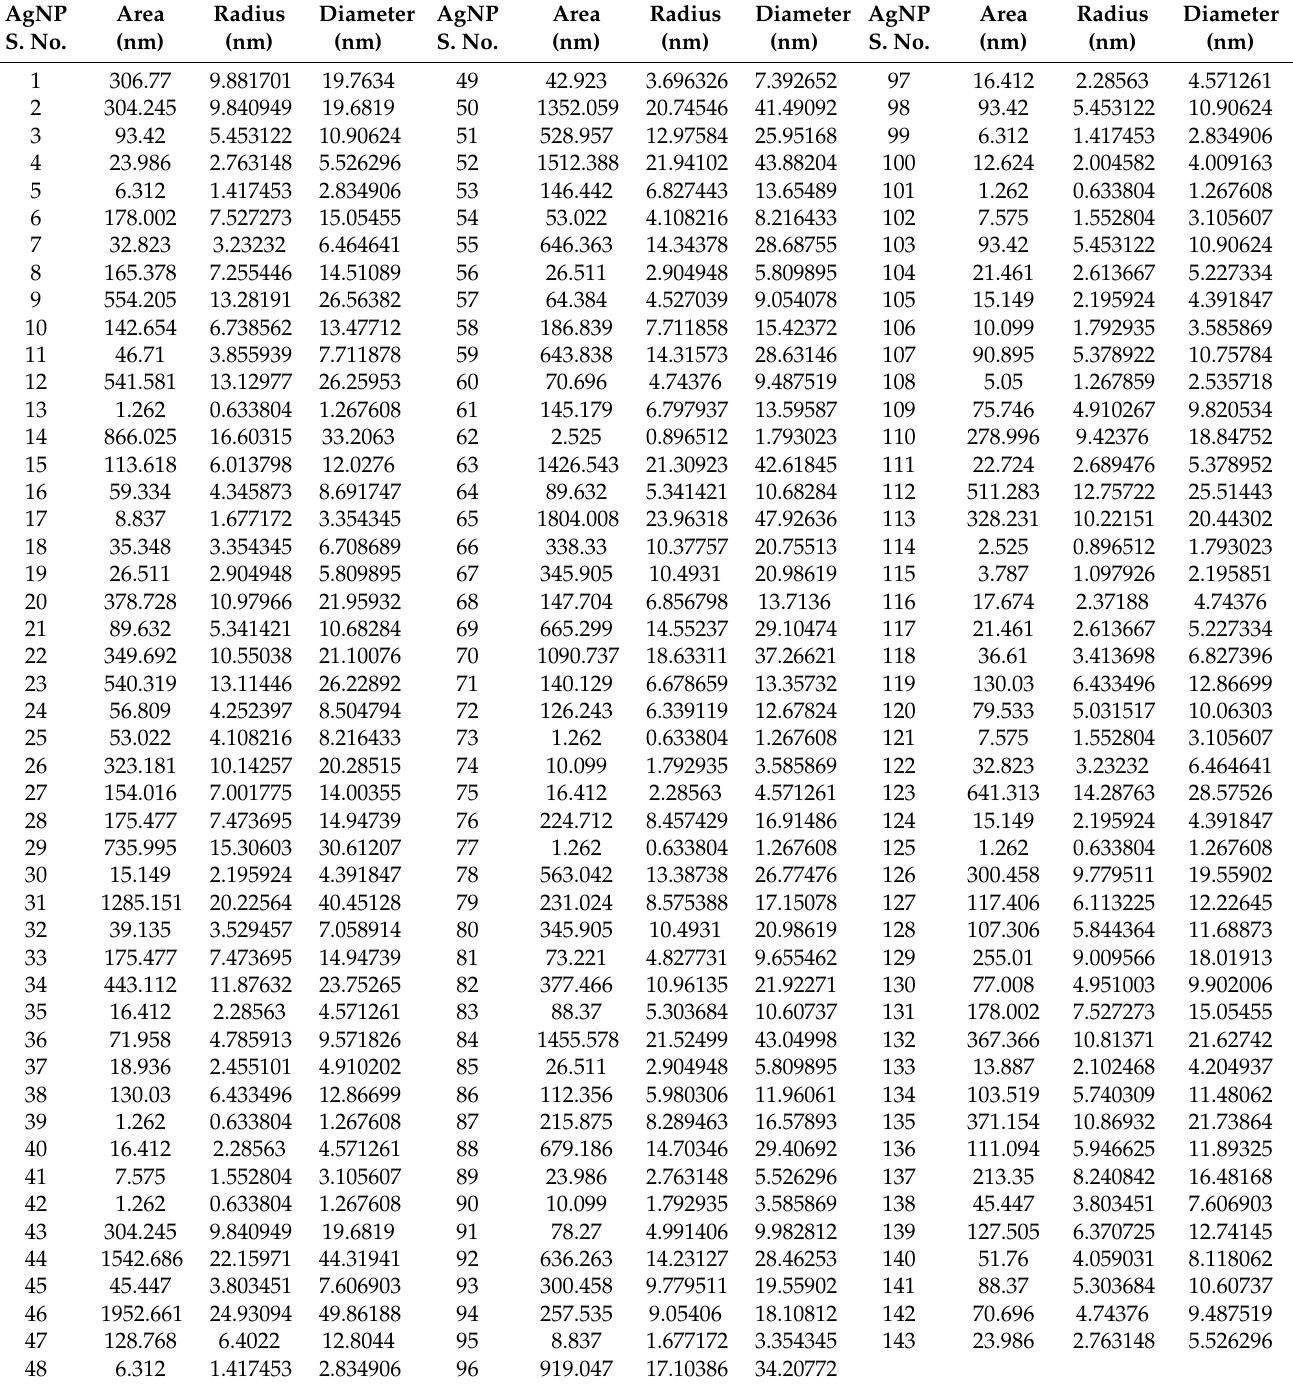
Table 1. Silver nanoparticle size distribution based on TEM data (Figure